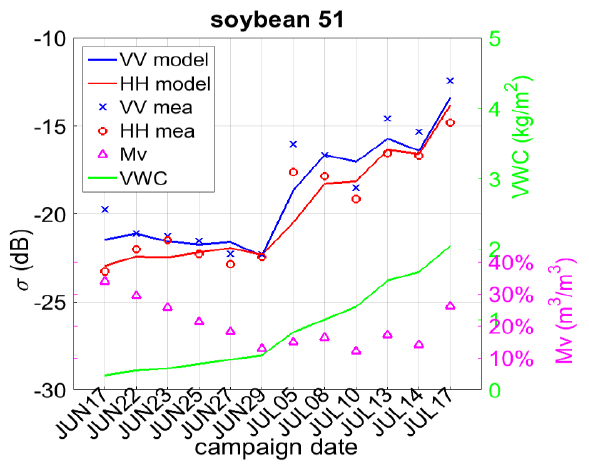
Figure 7. Forward model evaluation for soybean field 51.